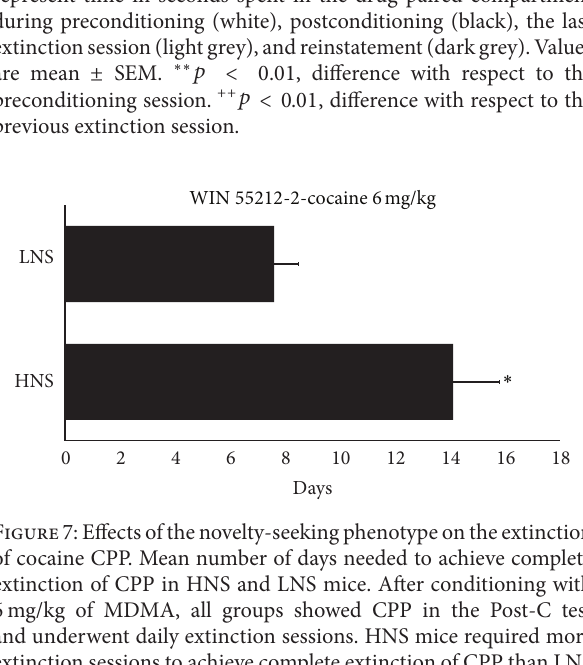
the reinstating effects of a low dose of cocaine if they have been previously exposed to a cannabinoid